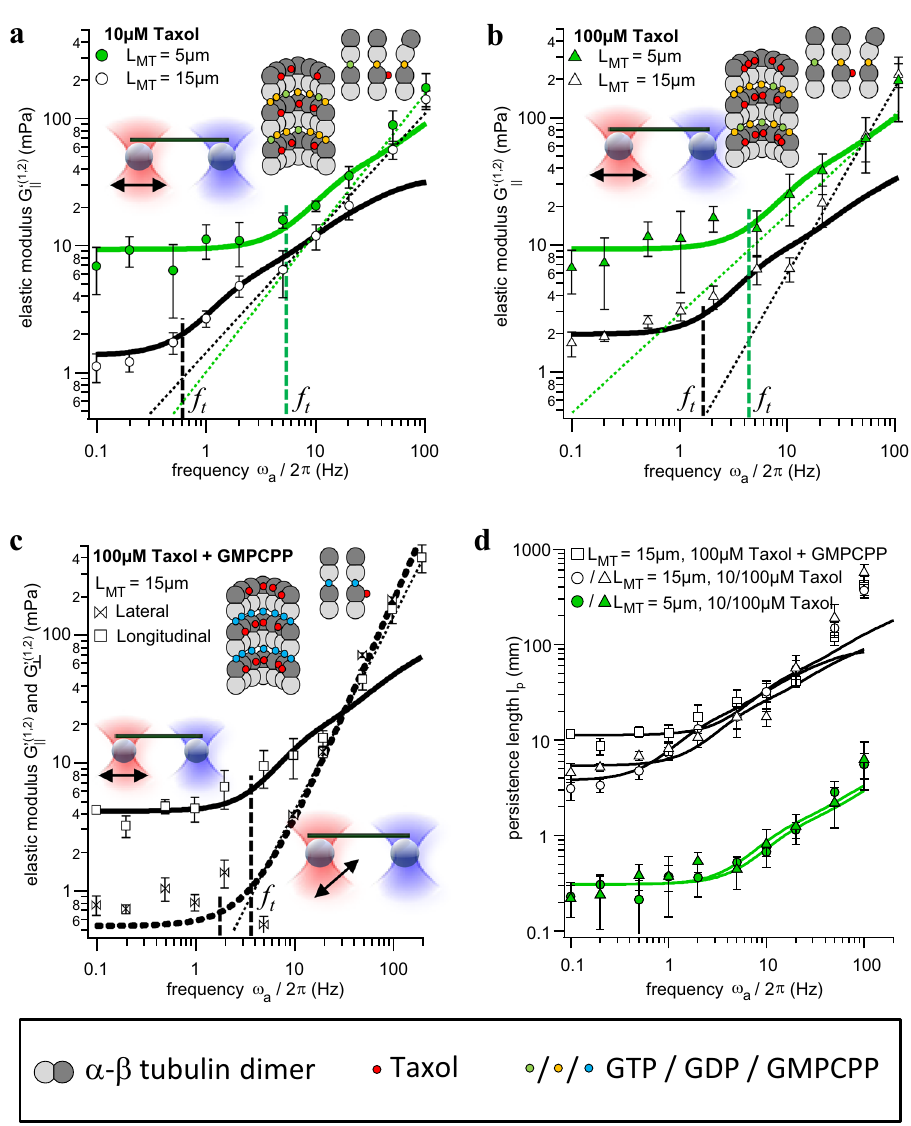
Figure 3. Elastic modulus for differently stabilized single microtubules of different lengths. ( a ) Stabilization with 10 µ M Taxol, MT end oscillation direction: longitudinal. N = 8 measurements for short and N = 19 measurements for long microtubules. ( b ) Stabilization with 100 µ M Taxol, MT end oscillation direction: longitudinal. N = 9 measurements each length. ( c ) Stabilization with GMPCPP + 100 µ M Taxol, MT end oscillation directions: longitudinal (solid black line) and lateral (dashed black line). N = 9 measurements each direction. ( d ) Frequency dependent persistence lengths obtained from the elastic moduli for all filament types. Error bars represent the standard deviation